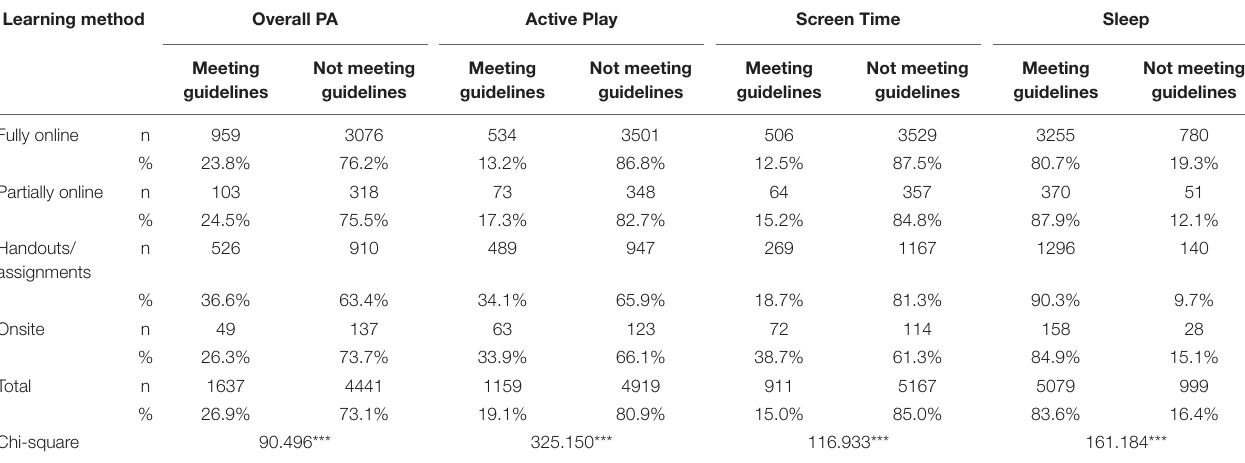
FIGURE 2 | Average minutes of PA, active play, screen time, and sleep of Thai students during school closure. ***Significant at p -value < 0.001. TABLE 4 | Cross-tabulation: learning method during pandemic-related school closures and health behavior. Learning